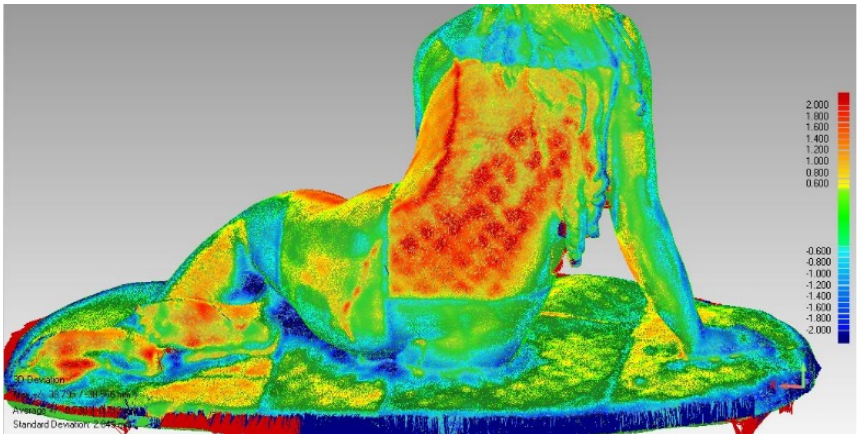
Figure 4. The result of comparing the replica’s 3D model and the 3D model that was used to create the replica.